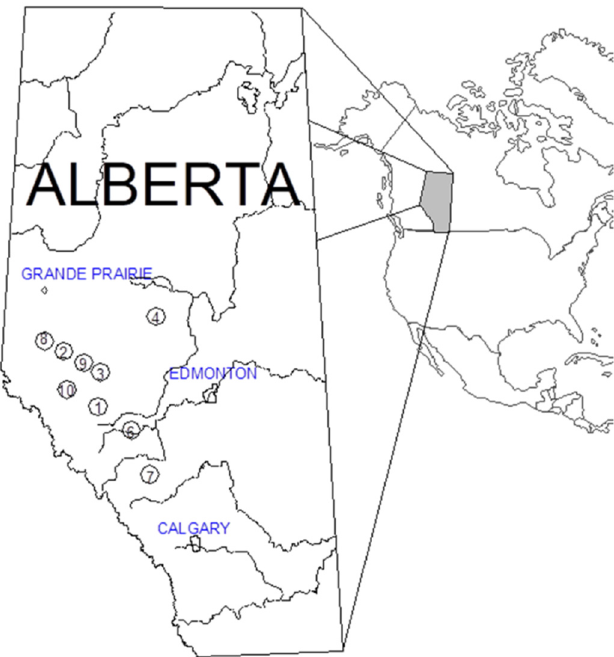
Figure 1. West-central Alberta location of nine sample sites where soil bulk density was measured six times over 7 years. The distance between sites 7 and 8 is about 330 km.